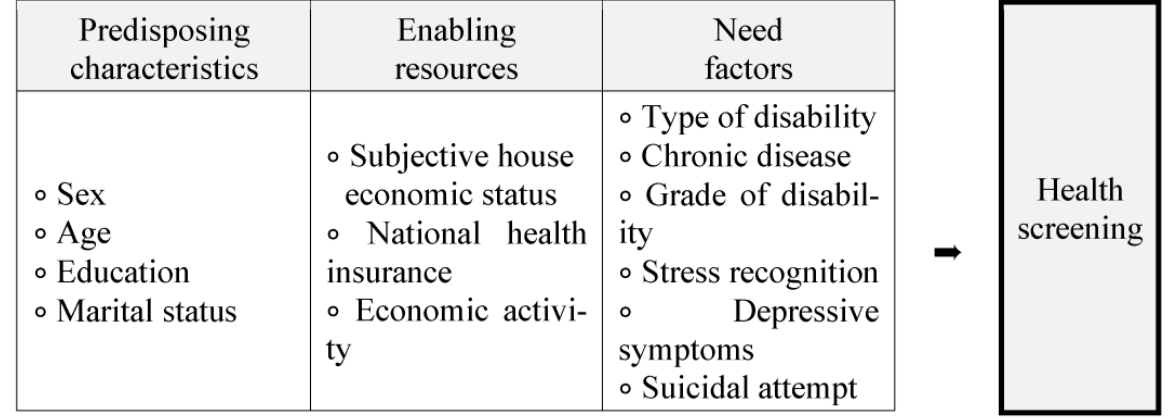
Figure 1. Study framework.